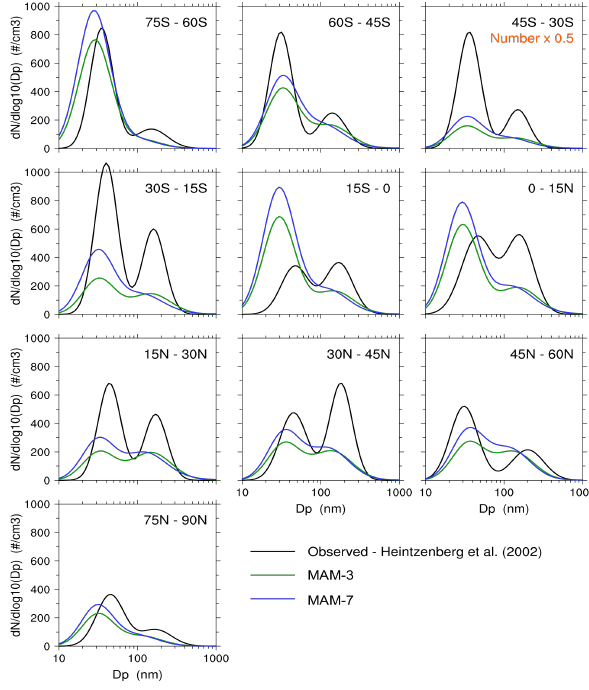
Fig. 21. Submicron aerosol number size distributions in the ma- rine boundary layer. Observations (Obs.) from Heintzenberg et al. (2000) were compiled and aggregated onto a 15 × 15 ◦ grid then averaged zonally. The model data are spatially averaged over the 15 × 15 ◦ grid cells having observations. Model data for MAM3 and MAM7 are temporally averaged over December–February for 75– 45 ◦ S, over November–March for 45–30 ◦ S, annually for 30 ◦ S– 30 ◦ N, over May–September for 30–45 ◦ N, over June–August for 45–90 ◦ N. For the 45–30 ◦ S latitude band, aerosol number densi- ties are scaled by 0.5, so the same vertical axis can be used for all latitudinal